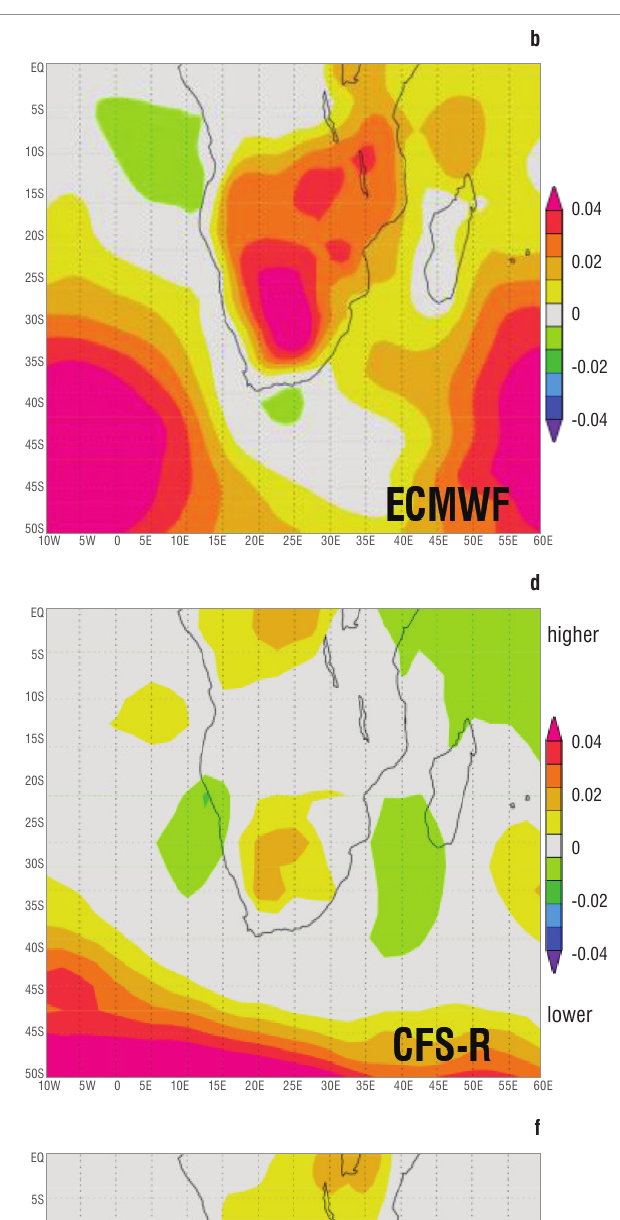
September/October 2013